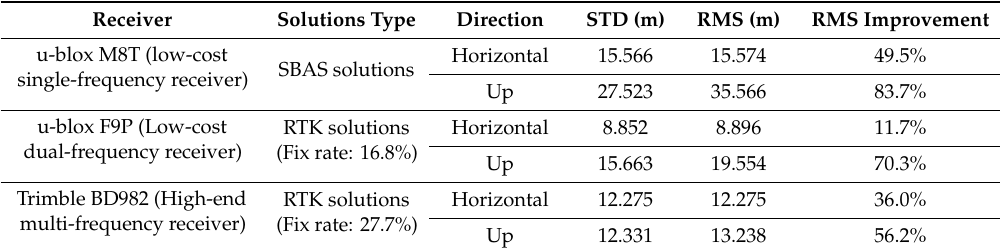
Table 5. Positioning accuracy improvement compared to the commercial receiver